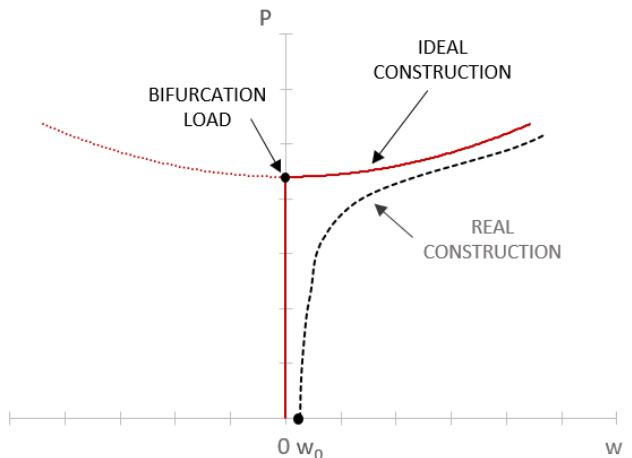
Figure 6. Postbuckling equilibrium paths of two structures: idealized, and actual (with initial geometric imperfections described by an amplitude w 0 ).